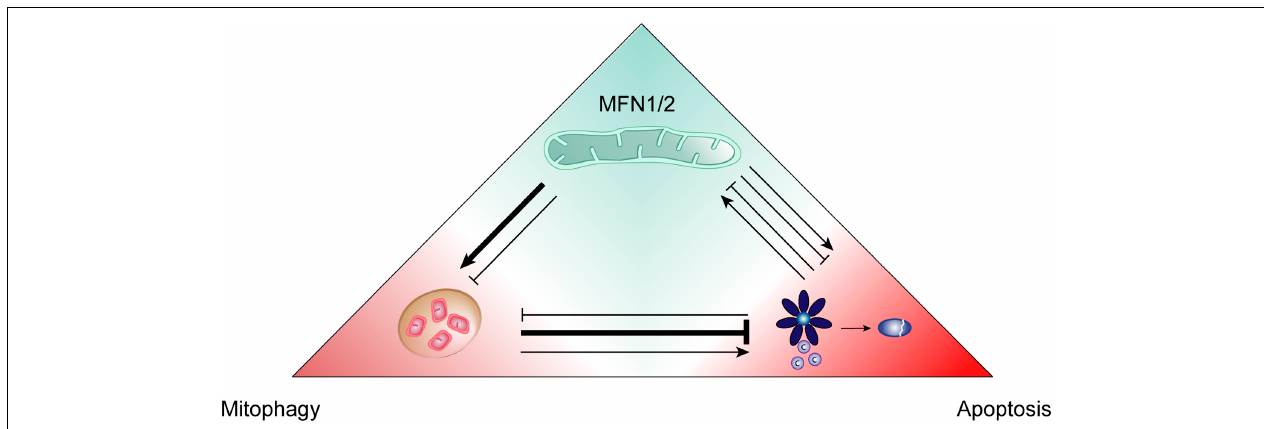
FIGURE 5 | Positive and negative interactions between mitofusins, mitophagy and apoptosis. The quality control processes of mitophagy and apoptosis can positively and negatively regulate each other and, in turn, this interplay can be itself influenced by mitofusins (MFN1/2). Mitophagy mostly behaves as an anti-apoptotic mechanism, promoting cellular survival. However, it can also contribute to cell death by apoptosis. Mitofusins add another layer of regulation since they are known to promote both mitophagy and apoptosis. Nevertheless, these proteins can also be found to negatively impact mitophagy induction.